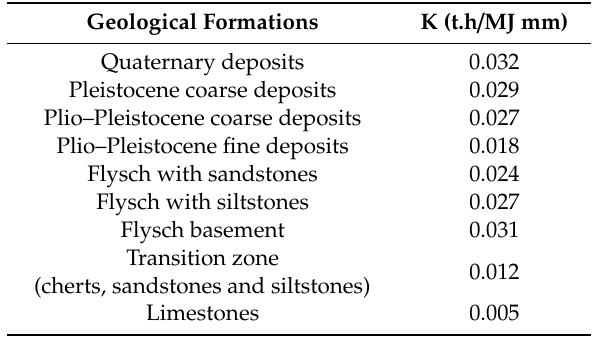
Table 2. Erodibility factors (K) of the geological formations prevailing in the pilot